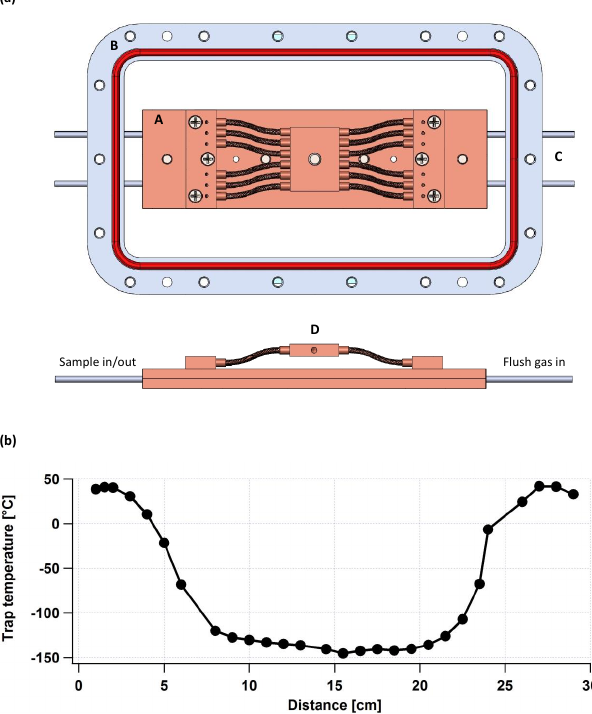
Figure 2. (a) Drawing of ACCBAR sample trap (top view, side view). The cold block (A) is mounted inside a vacuum chamber (B), suspended upon two 3.2mm OD stainless steel tubes (C). The Stirling cooler cold finger (not shown) bolts to the floating stage (D) centered above the cold block. (b) Temperature profile of Ch no.